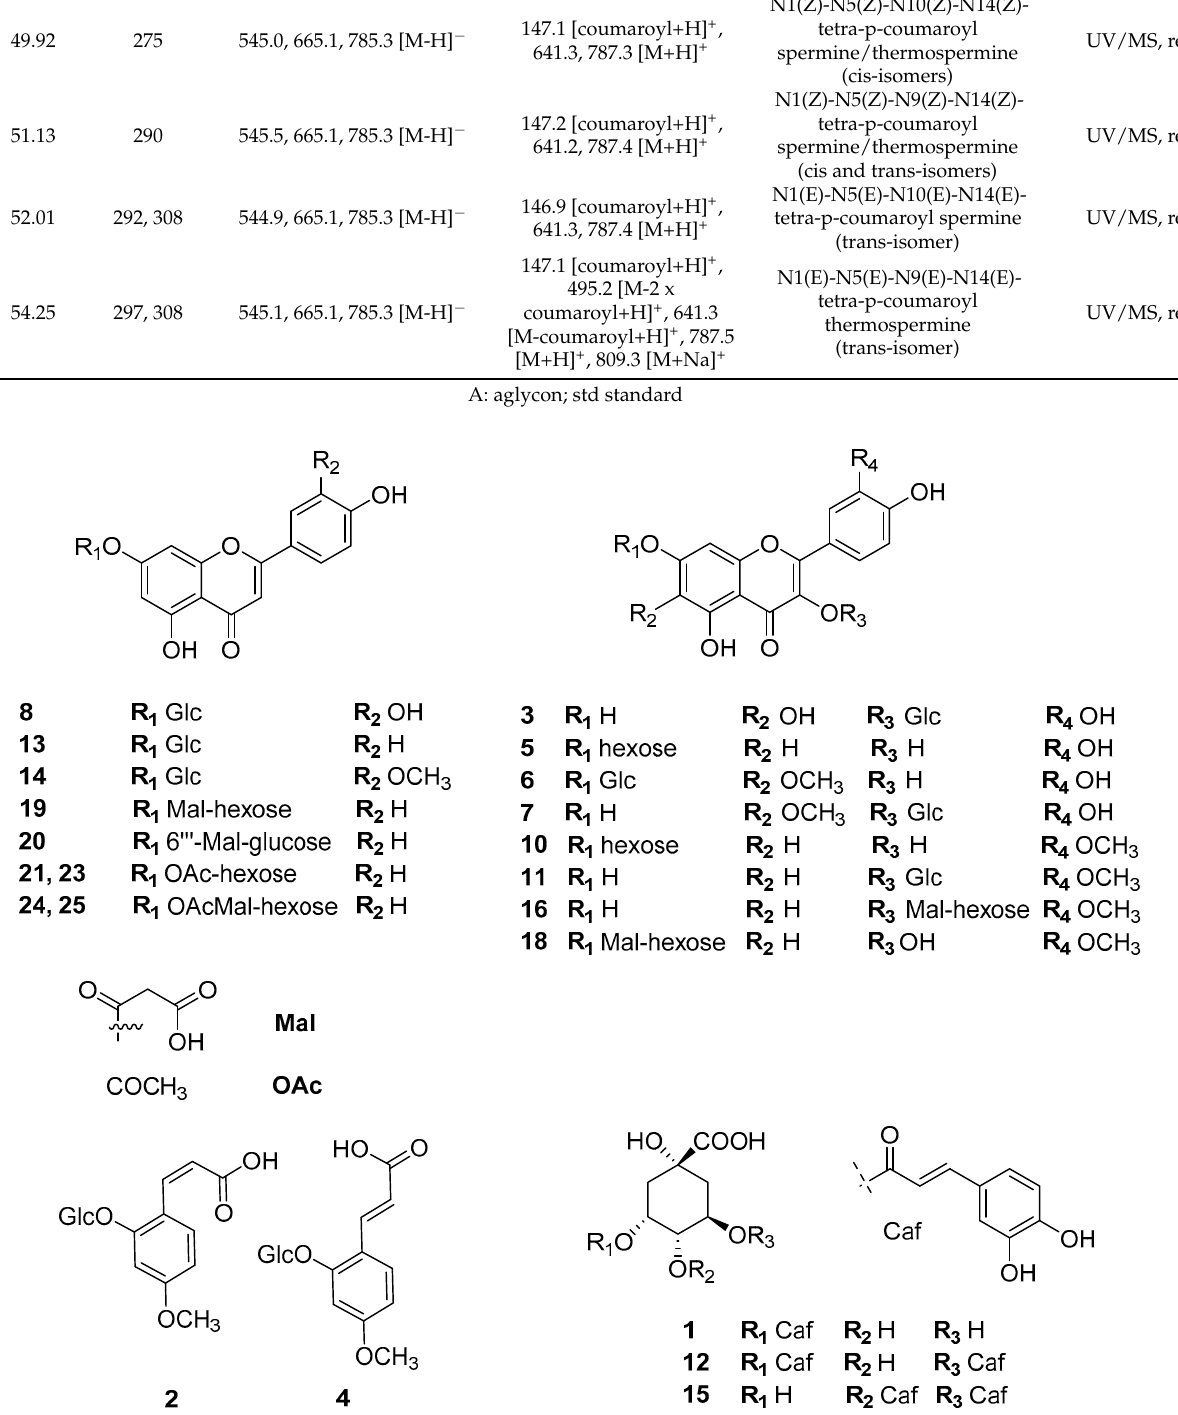
Figure 2. Flavonoids and phenolics detected in Matricaria recutita flowers.